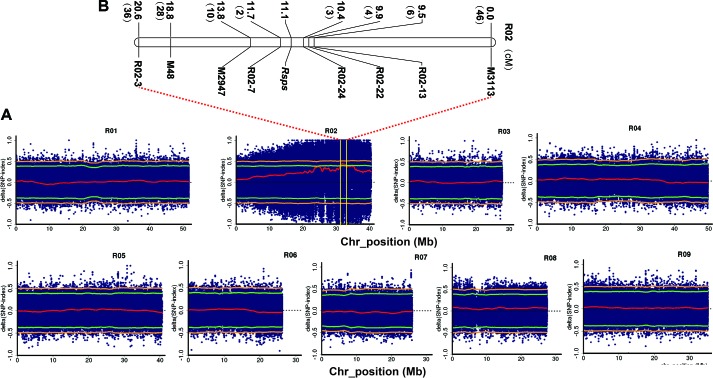
Combined QTL-seq and traditional linkage analysis to map a purple skin locus (Rsps) in radish. (A) Δ(SNP index) plot of the purple and white bulks with confidence intervals under the null hypothesis of no QTLs (green, p < 0.05; orange, p < 0.01); (B) genetic linkage analysis with InDel markers confirming the position of Rsps. The numbers in brackets refer to the number of recombinants of each marker.